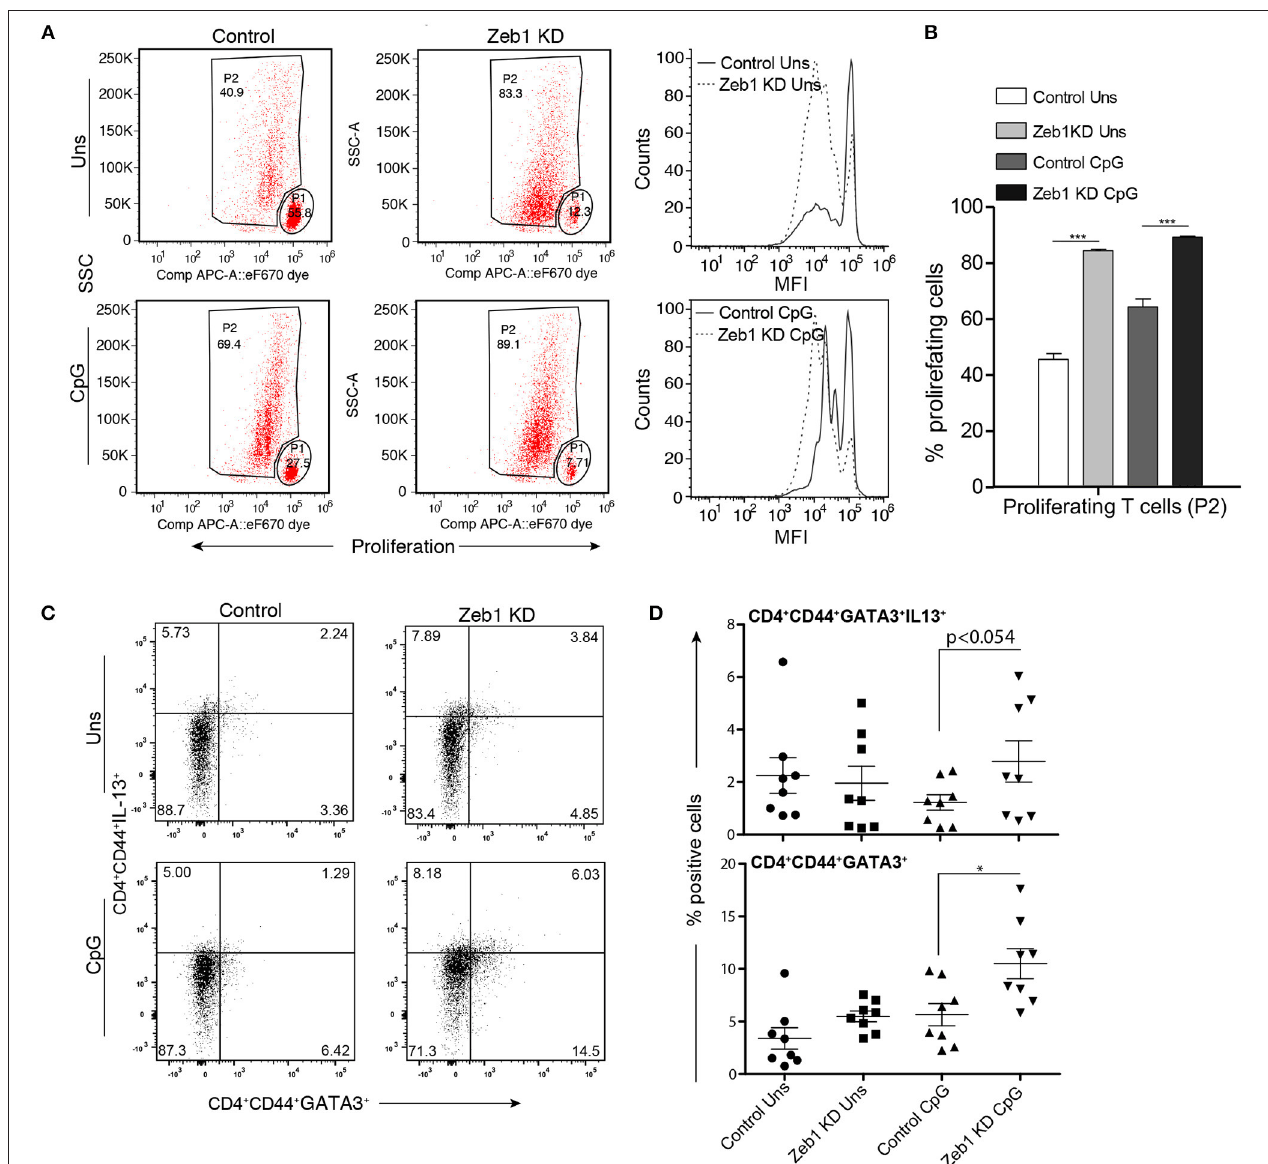
FIGURE 4 | OT-II T helper cells co-cultured with CpG activated Zeb1 KD cDC1 MutuDCs showed enhanced proliferation and differentiation toward Th2 phenotype. (A) Representative FACS dot-plots showing gated parent population (P1) and proliferating cell population (P2) depicting the changes in proliferation rate of OT-II Th cells co-cultured for 72h with Zeb1 KD cDC1 MutuDCs as compared to control DCs with or without CpG pulsing. The corresponding panel shows the histogram showing the MFI shifts for the proliferation of T cells. n = 3. (B) Bar-plot depicting the percentage of proliferating Th cells (P2) in CD4 + T cells co-cultured with unstimulated and CpG activated Zeb1 KD and control DCs n = 3. (C) FACS dot-plots showing the percentage positive CD4 + CD44 + GATA3 + IL-13 + Th cells in Th cells co-cultured with unstimulated and CpG pulsed Zeb1 KD and control cDC1 MutuDCs for 96h n = 8. (D) Scatter-plots showing the percentage of double positive cells for GATA3 + IL-13 + and single positive GATA3 + cells in effector CD4 + CD44 + Th cell population n = 8. p -values are calculated using two tailed unpaired student’s t -test, error bars represent SEM. * ≤ 0.05, *** ≤ 0.001.